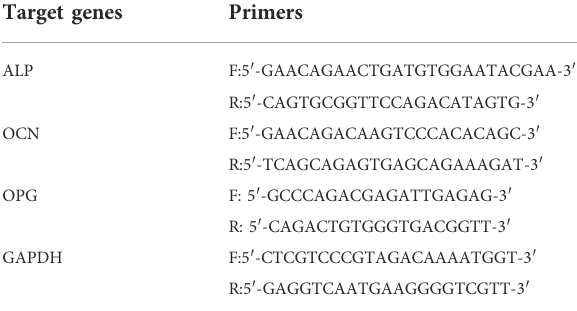
TABLE 1 Primer sequences for the MC3T3-E1 cells used in this